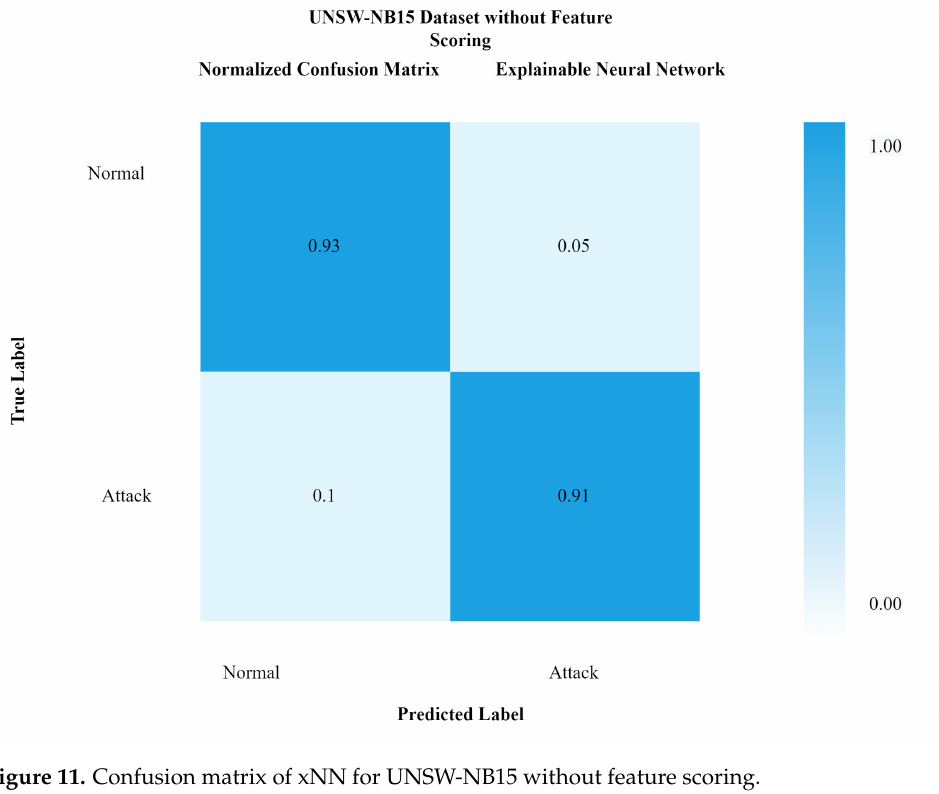
Figure 11. Confusion matrix of xNN for UNSW-NB15 without feature scoring.